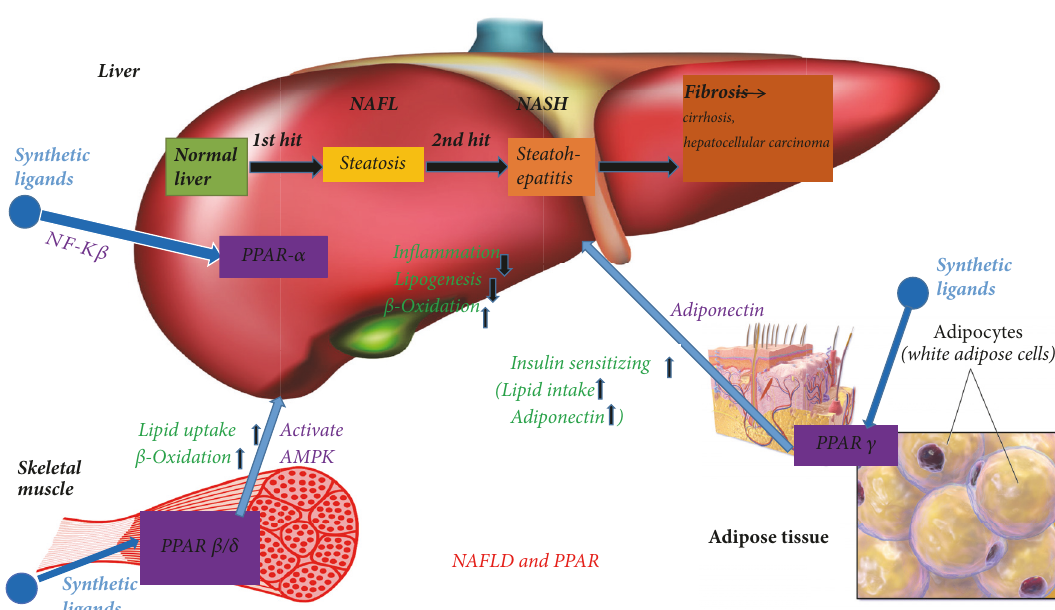
Figure 1: The relation between PPAR and